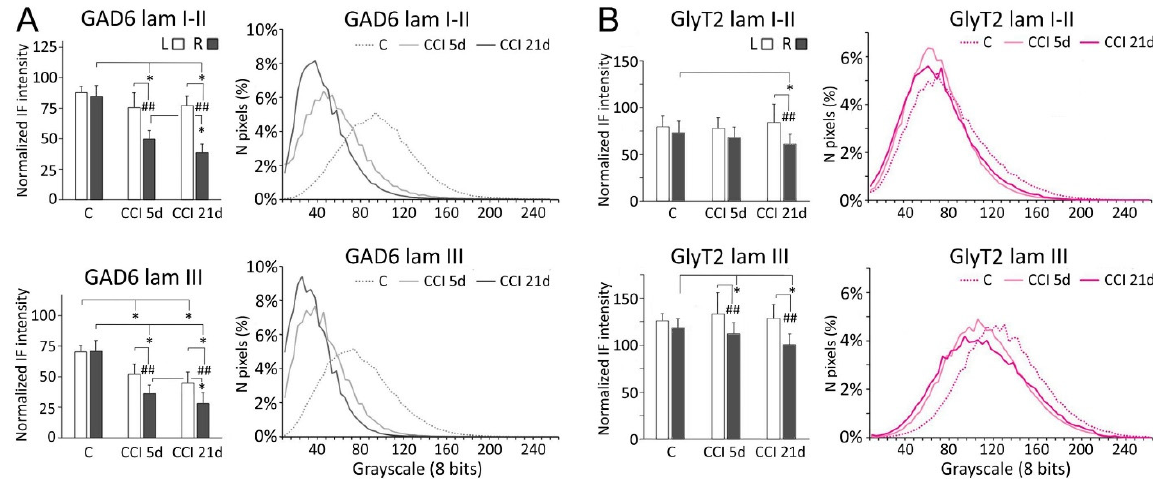
Figure 3. Comparisons of densitometric measurements for GAD-6 ( A ) and GlyT2 ( B ) in laminae I-II ( top panels ) and III ( bottom panels ). Values for each molecule are represented as means ± SD of the normalized fluorescence intensity (histograms), and as the relative distribution of pixels in a grayscale between 0 (darkest) and 255 (brightest). Histograms show values for the contralateral (left, L) and ipsilateral (right, R) sides with respect to the CCI-IoN. Curves show values only for the right side in operated cases, and averages for R and L sides in control cases. C, controls; CCI 5d, operated animals, at 5 dpo; CCI 21d, operated animals, at 21 dpo. In histograms, * indicates statistical significance ( p < 0.05) between groups, using hemispheres as sampling units (Mann-Whitney test, n = 4 in C and n = 6 in CCI-IoN cases). Differences between sides in each group were assessed by the Wilcoxon signed rank test using individual sections for pairwise comparisons ( n = 12 in C and n = 18 in CCI-IoN cases; ## = p < 0.01). For statistical comparisons of pixel distributions, see Figure 4.